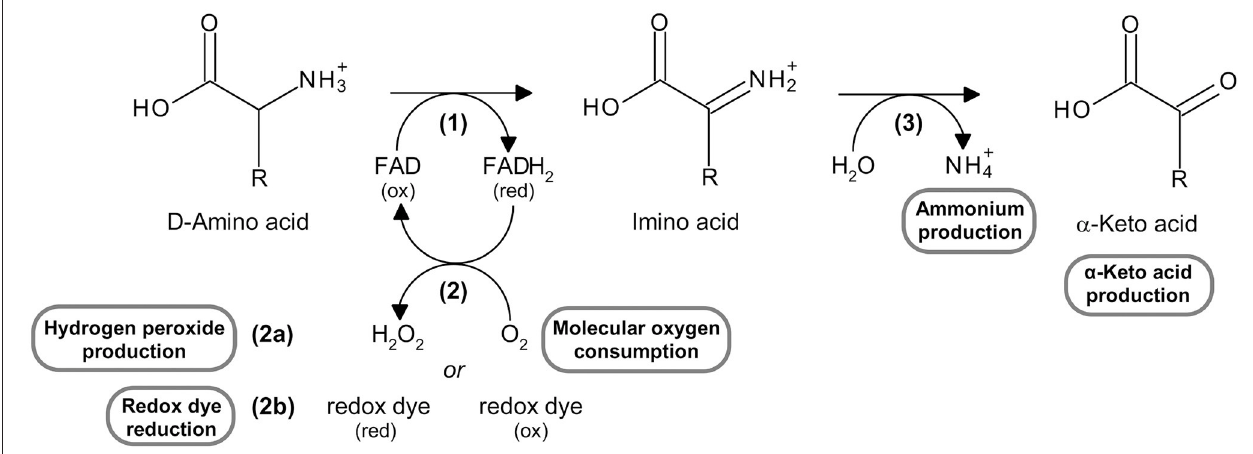
FIGURE 1 | Reaction catalyzed by DAAO, highlighting the substrates and the products which can be measured using the assays reported here. See text for the explanation of the steps in the reaction.